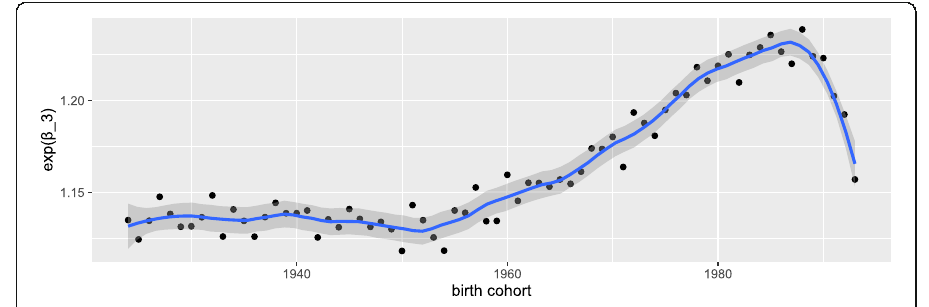
Fig. 8 Yearly variation in the effect of parents ’ education on higher